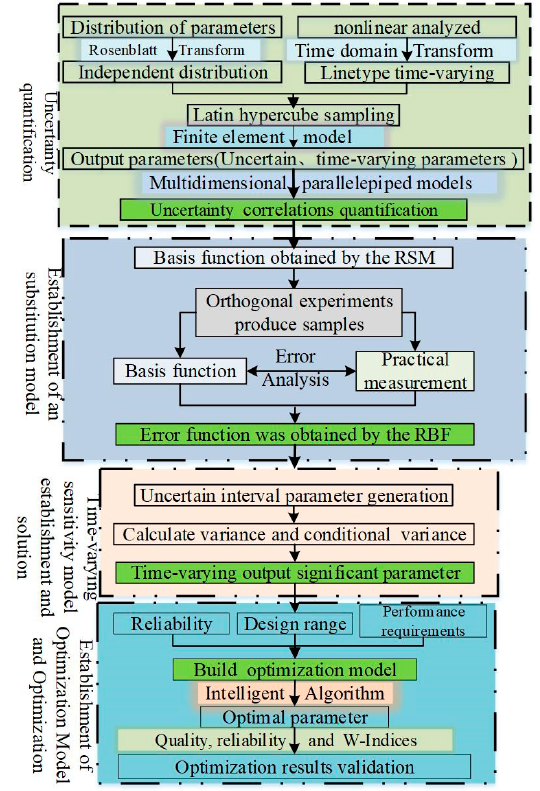
Figure 2. Processes optimization and design.